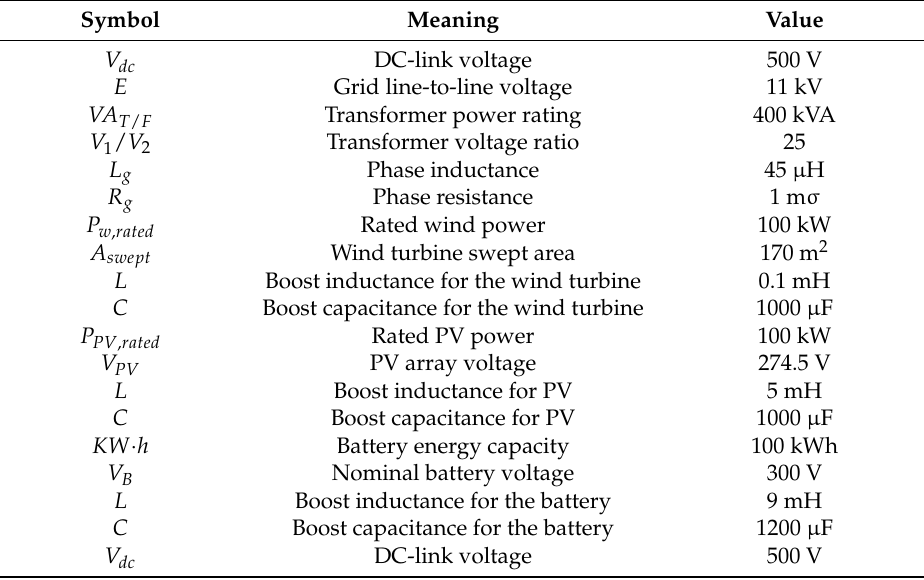
Table 1. DC microgrid system parameters.